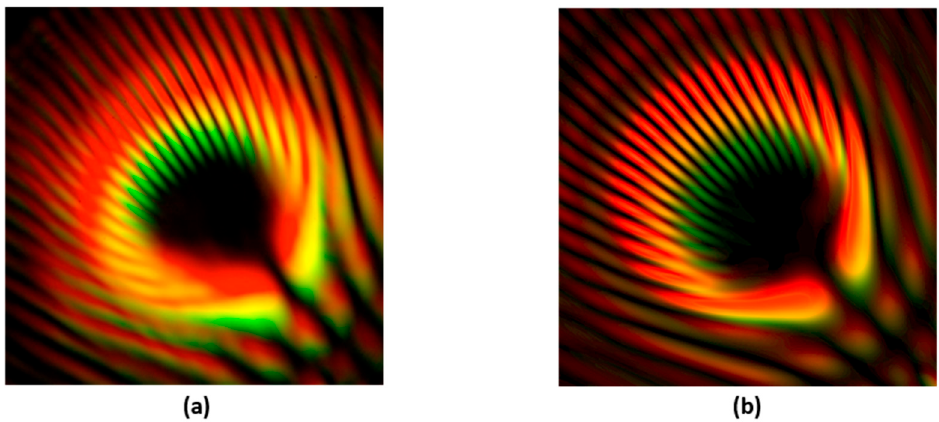
Figure 9. Interference of two spatially dispersed multi-color vortices of opposite charge (+10 and − 10), ( a ) experimental result, ( b ) numerical modeling.